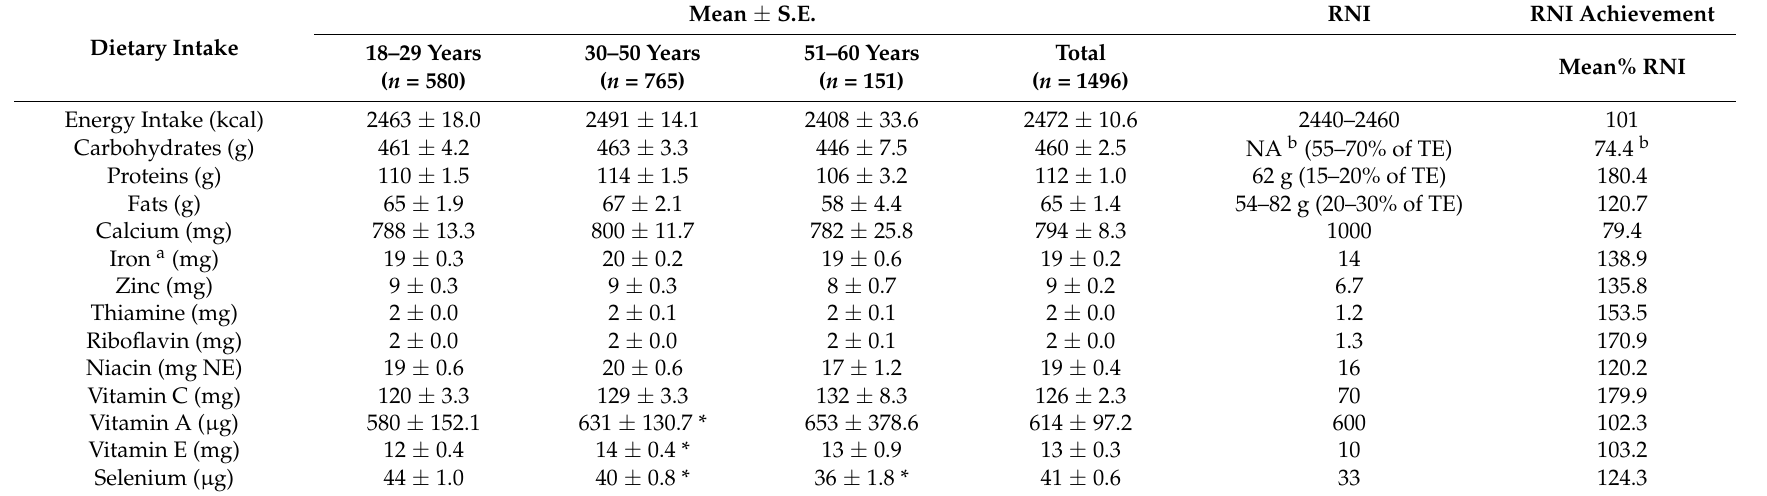
Table 2. Nutrient intake of men in a day by age groups and comparing nutrient intake with Recommended Nutrient Intake (RNI).